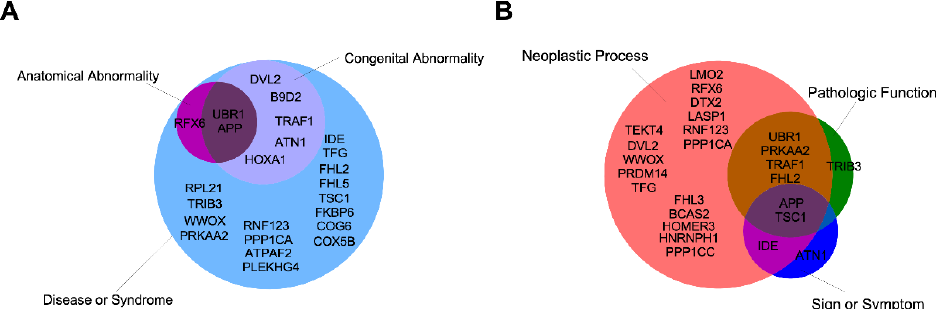
Figure 3. IIIG9-interactor proteins organized into semantic groups (UMLS ® ) of diseases extracted using DisGeNet ( A , B ). Interactors were experimentally validated (yeast via two-hybrid and affinity capture—MS methods). The semantic groups correspond to concept unique identifiers from the Unified Medical Language system ® (UMLS) Metathesaurus ® (version UMLS 2018AA).